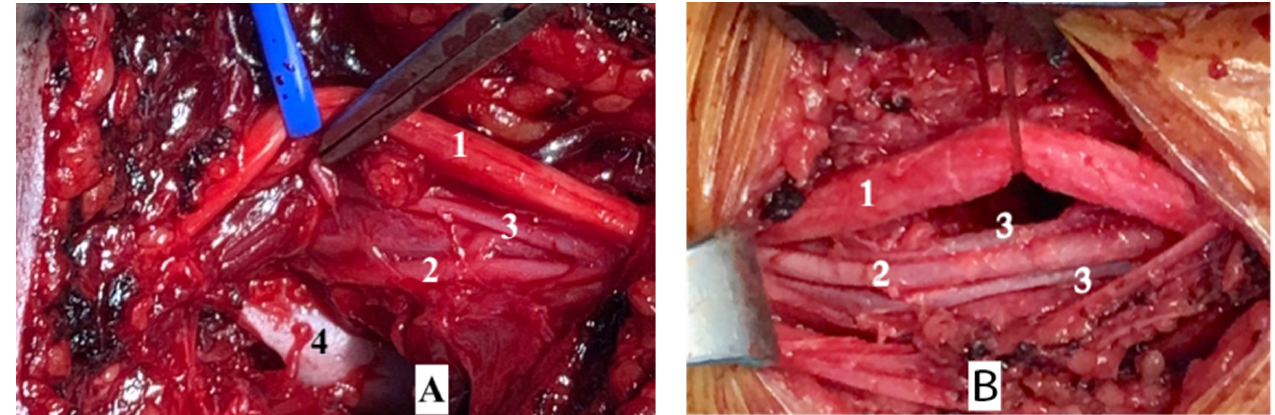
Figure 5. ( A ) Arterial entrapment in the fracture socket. ( B ) Freeing the artery from the fracture socket. ( 1 : median nerve;